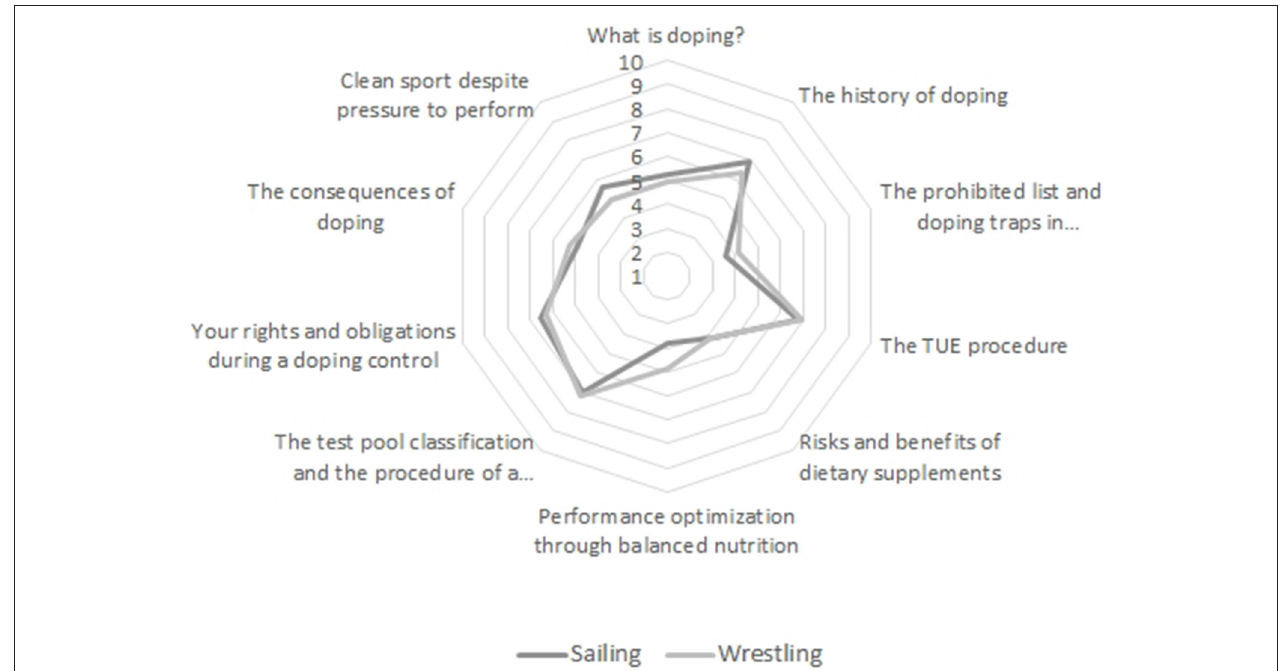
FIGURE 1 | Content preferences regarding German doping prevention program Together Against Doping